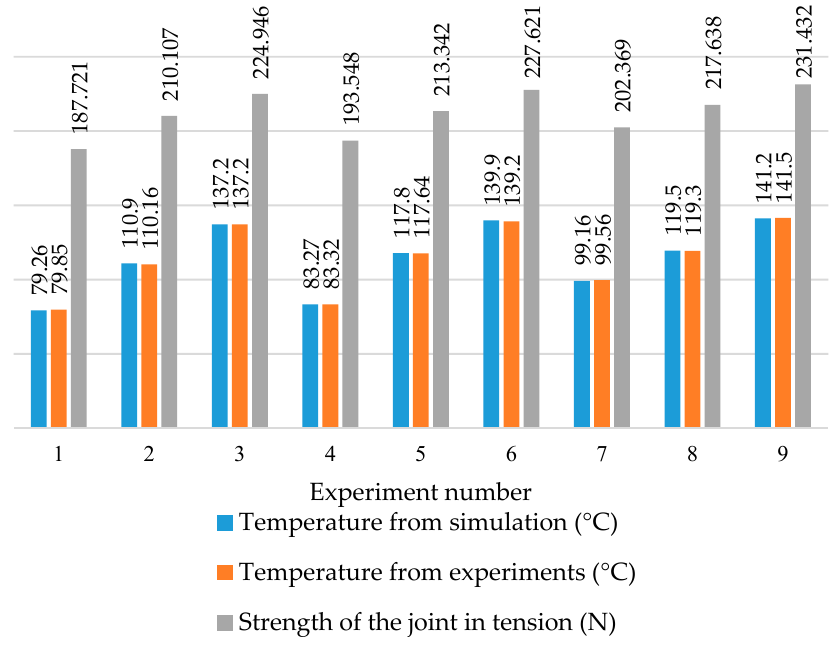
Figure 13. Comparison of temperature and strength of the joint under tensile loading.